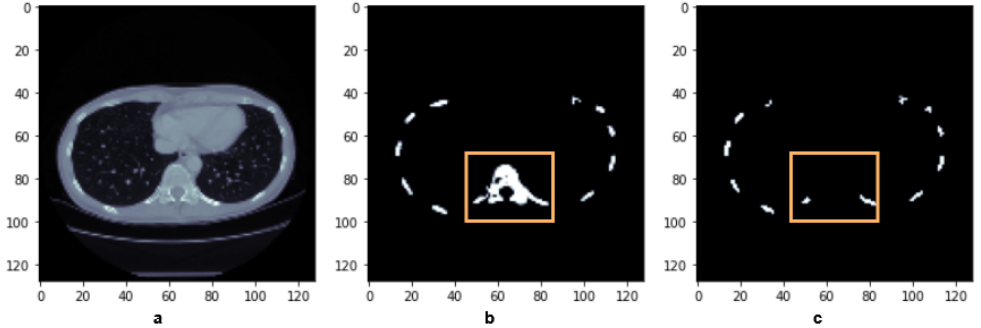
Figure 7. Sample image ( a ), original mask ( b ) and predicted mask ( c ) for the